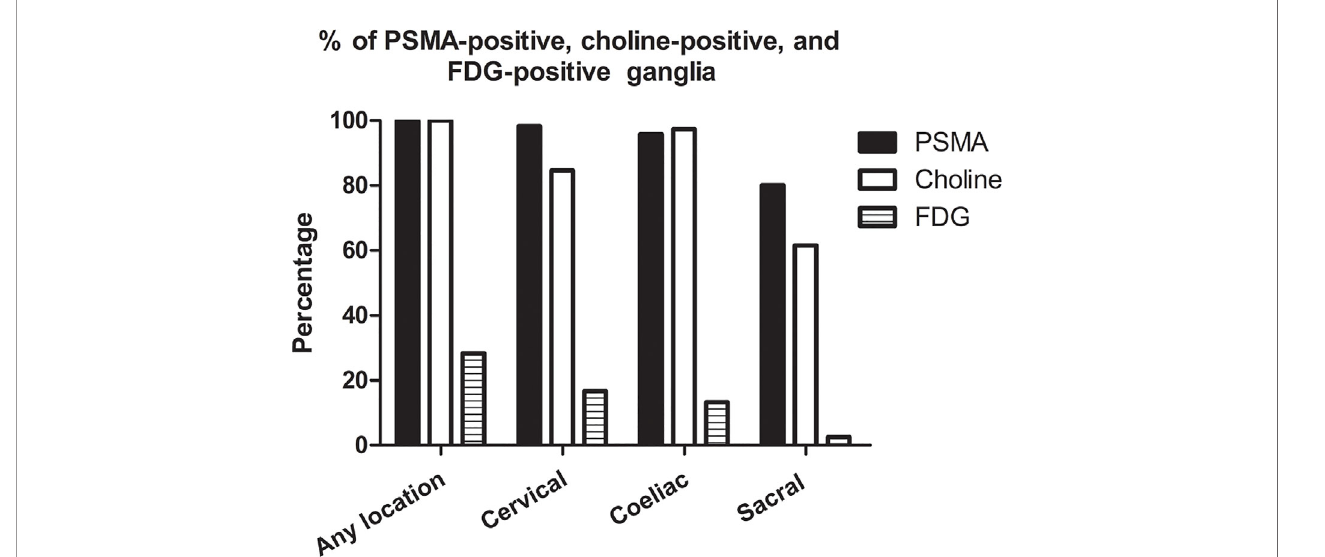
FIGURE 1 | Frequencies of PSMA-positive, choline-positive and FDG-positive ganglia on